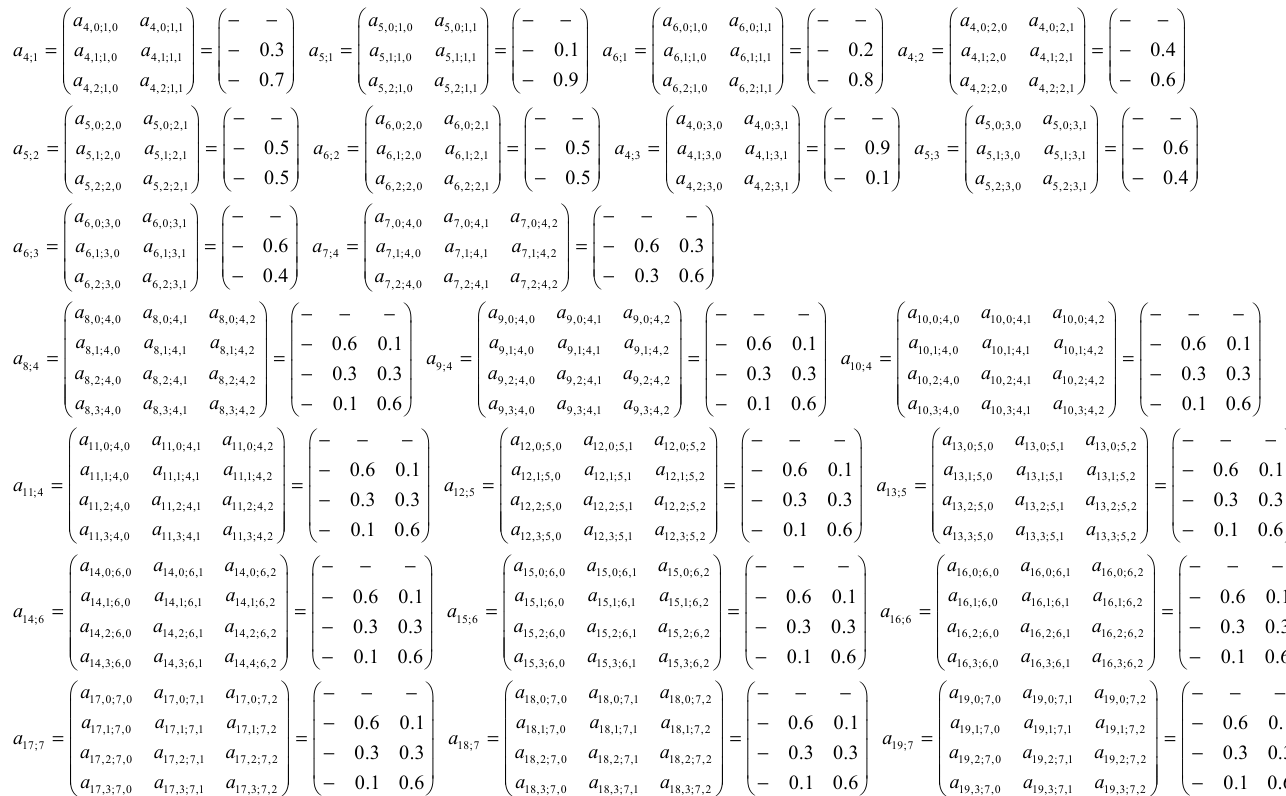
Figure 8. Causality function parameters of the variables in Figure 6.